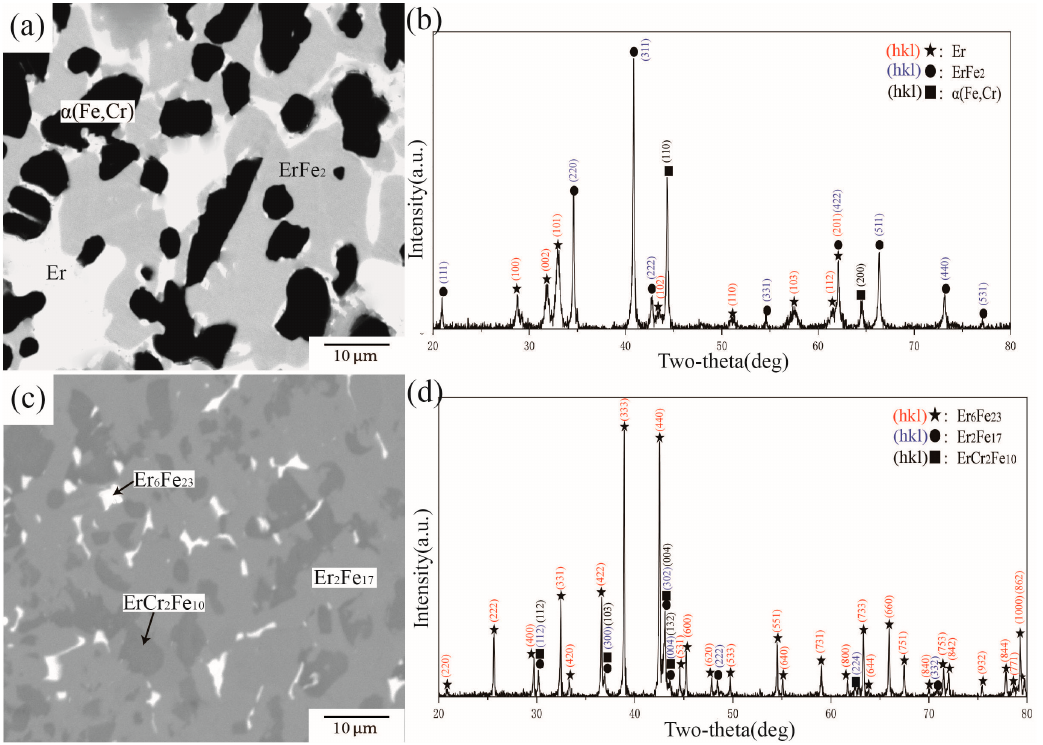
Figure 13. ( a ) BSE image of alloy B3, ( b ) XRD result of alloy B3, ( c ) BSE image of alloy B7, ( d ) XRD result of alloy B7.